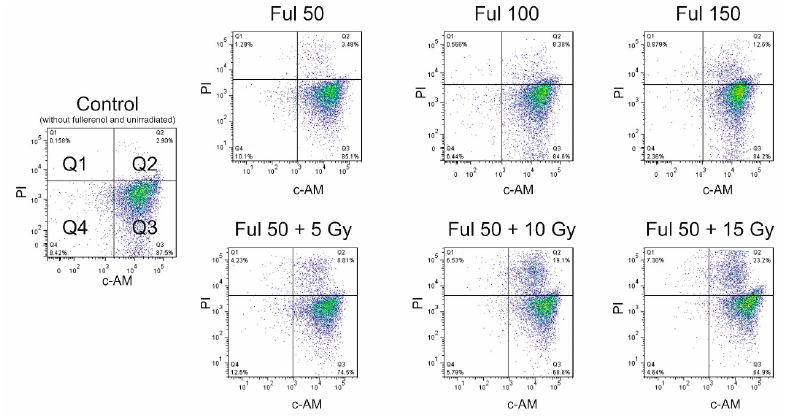
Figure 9. Representative cytograms of PBMCs after incubation with fullerenol C 60 (OH) 36 (0–150 mg/L) for 24 h (37 °C, 5% CO 2 atmosphere, 100% relative humidity), or preincubated with fullerenol (50 mg/L) for 1 h, and then irradiated with the doses of 5, 10, and 15 Gy in the presence of fullerenol. Viability was assessed 24 h after the end of irradiation. Q1—necrotic cells; Q2—apoptotic cells; Q3—viable cells; Q4—unstained cells. The cells were double stained with PI and calcein-AM (c-AM).